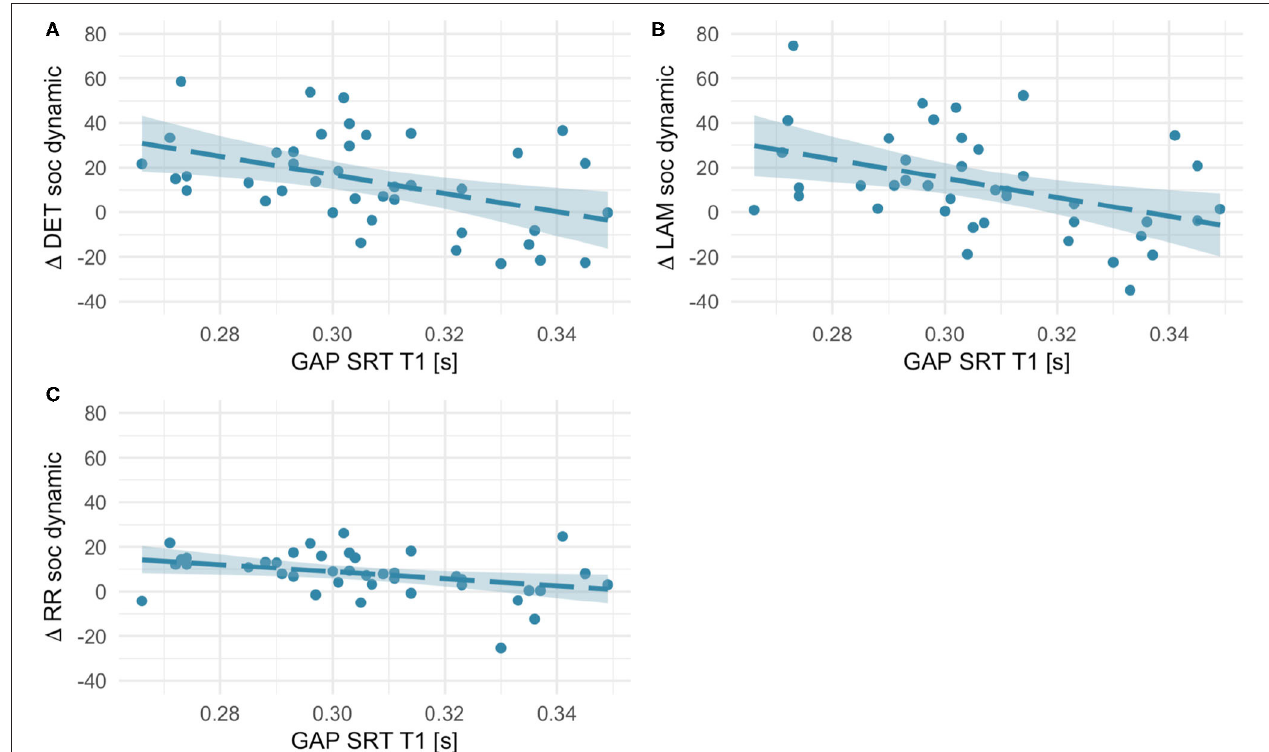
FIGURE 7 | Scatterplots showing associations between orienting speed at T1 (saccadic reaction times in the gap condition) and within-subject age-related change in Determinism (A) , Laminarity (B) , and Recurrence Rate (C) for social dynamic stimuli (T2–T1 values, thus positive values indicate an increase with age and negative values - a decrease). Fit line represents the regression line (with 95%